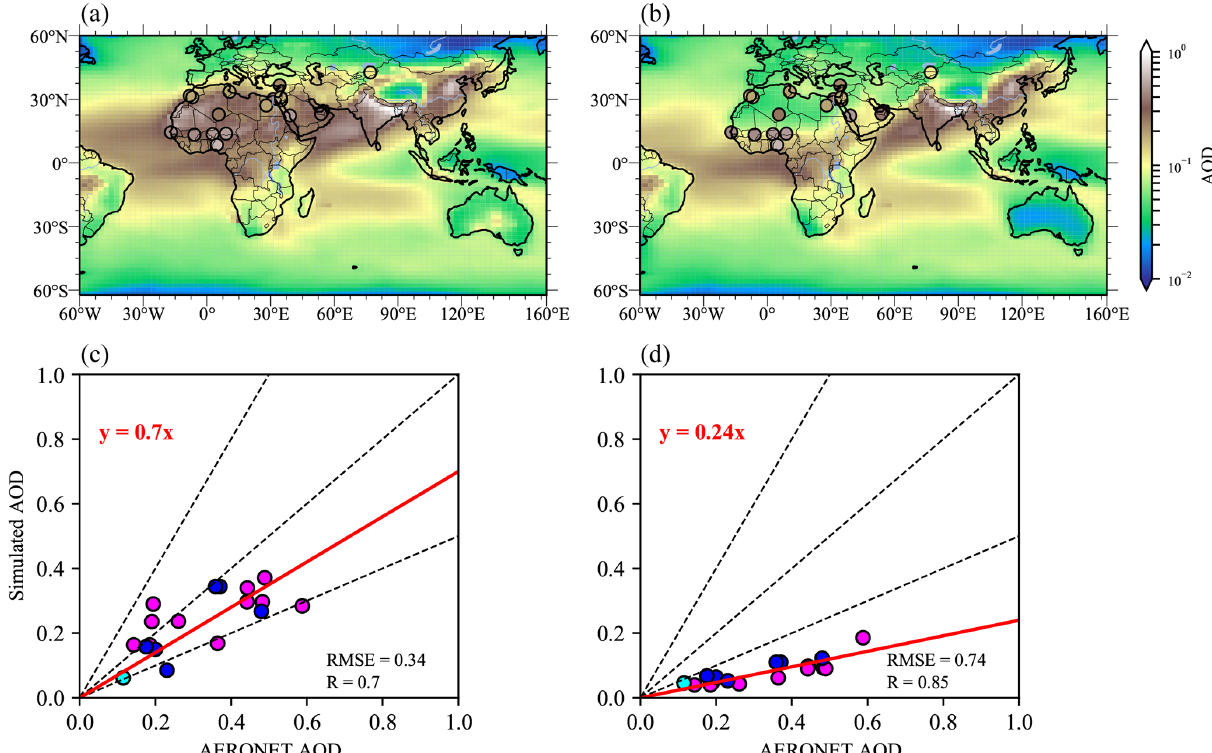
Figure 6. (a) Annual mean AOD at 532nm wavelength from 2014 to 2018 simulated by CESM1/CARMA, denoted by the color-filled contours. Panel (b) is the same as panel (a) for simulations without dust. The measured AOD from 18 AERONET ground sites located inside the major dust emission regions (Fig. 2) are denoted by the color-coded circles. (c) Comparison of the simulated annual mean AOD at 532nm wavelength with measurements from 2014 to 2018 for the most of the AERONET sites. North Africa, the Middle East, and Asia are represented as pink, cyan, and blue numbers, respectively. Panel (d) is the same as panel (c) but for simulations without dust. The solid red line denotes the best fit. The dashed black lines represent 1 : 2, 1 : 1, and 2 : 1 relationships between the observations and simulations.